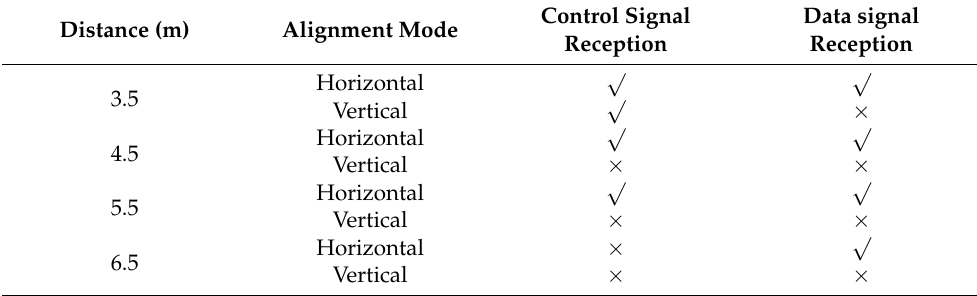
Table 3. Decoding results in different deployment modes and